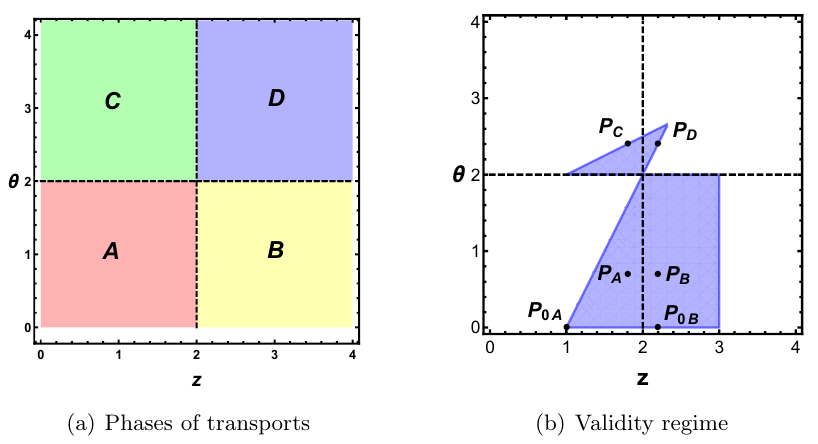
(b) Validity regime Figure 3 . (a) 4-phases A,B,C,D due to the sign changes at z = 2 and (cid:18) = 2. (b) Valid region satisfying all three conditions: (i) q 1 charge reality condition, (ii) Null energy condition, (iii) Asymptotic HSV condition. Black dots indicate speci(cid:12)c ( z; (cid:18) ) where we will discuss the typical behavior of transports from next